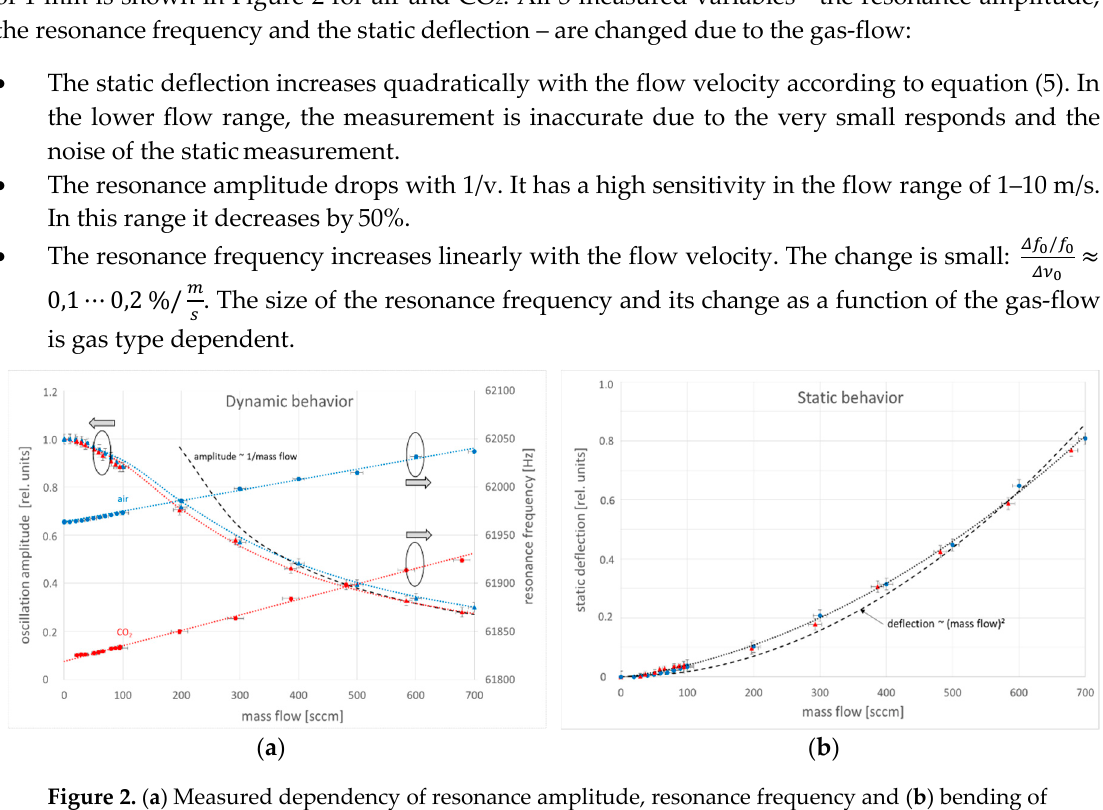
Figure 2. ( a ) Measured dependency of resonance amplitude, resonance frequency and ( b ) bending of the cantilever sensor on the gas-flow through a tube with 1 mm diameter (dotted line—fitted curve, dashed line—simplified behavior, symbols - measured values, blue—air, red—CO 2